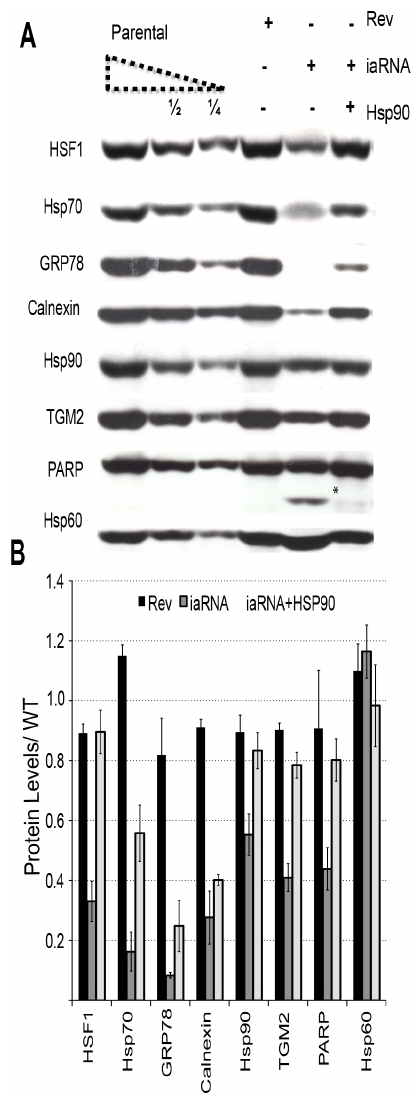
Figure 5. Effective targeting of HSF1 activity reduces the levels of molecular chaperone proteins. ( A ) Western blot analysis showing the depletion of specific molecular chaperone proteins in aptamer or control expressing cells. Hsp90 co-expression rescues specific molecular chaperones observed in HSF1 inhibited aptamer expressing cells. The asterisk indicates PARP degradation product, a marker of apoptosis. The left most three lanes are a serial dilution of parental line extracts that provides a quantification standard curve. ( B ) Quantification of the results observed in panel A (n=4, error indicates